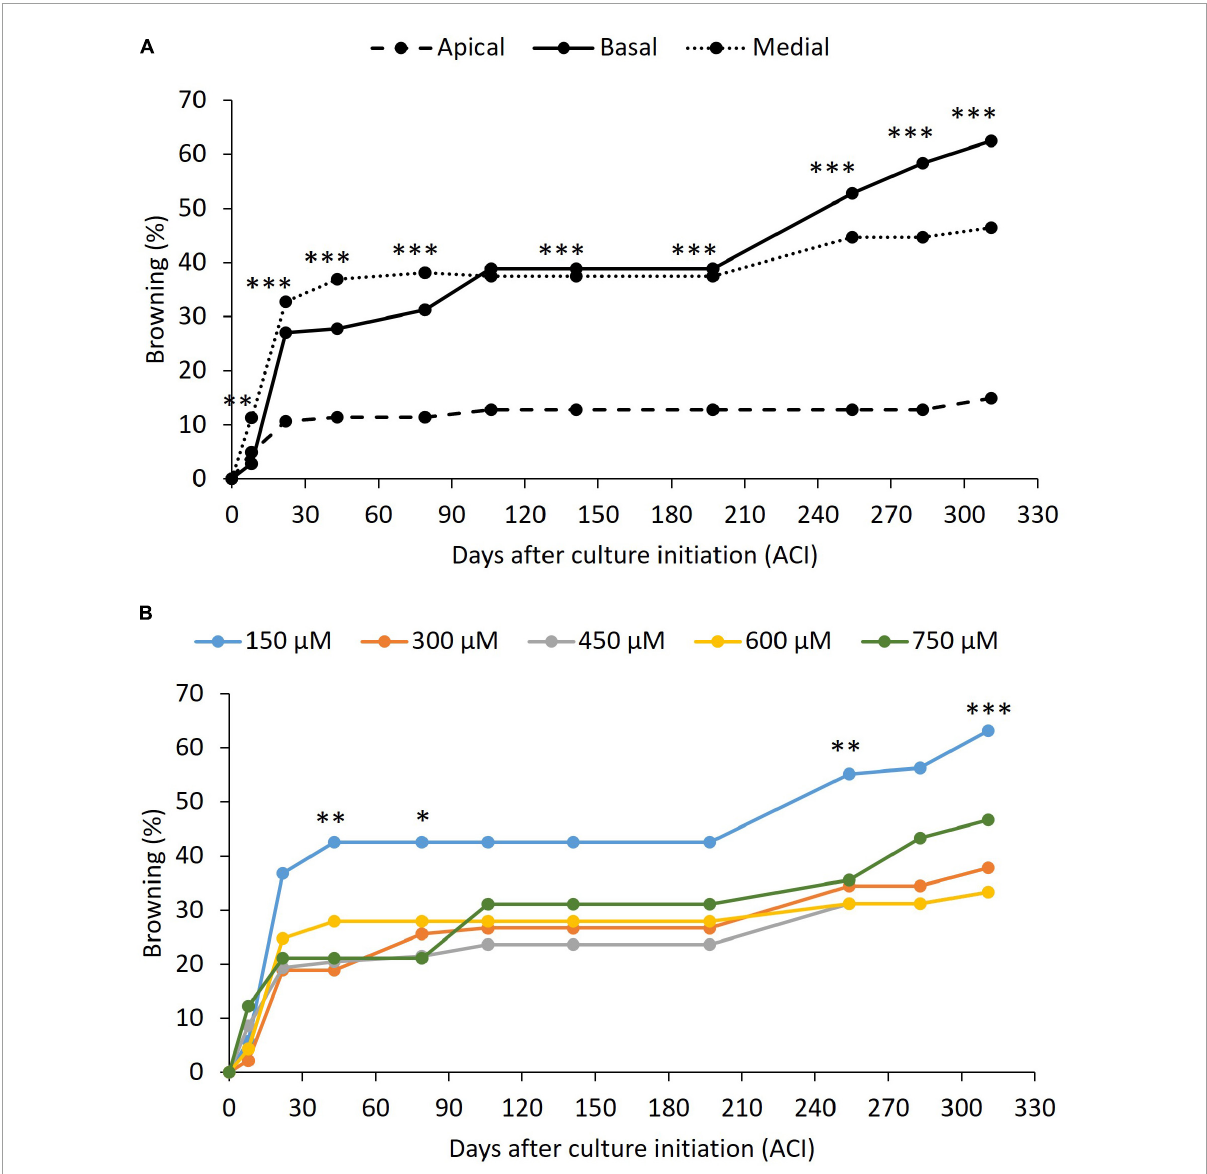
FIGURE5 Effect of the peach palm TCLs position (A) and picloram concentration (B) on browning of explants. p -value less than 0.05 ( ∗ ), less than 0.01 ( ∗∗ ), and less than 0.001 ( ∗∗∗ ), according to Tukey’s test at 95% confidence level. Exact p -values and differences among treatments can be found in Supplementary material . At least nine replicates per treatment were